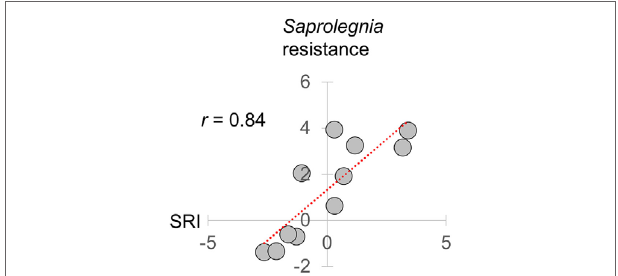
FigUre 3 | Relationship of seasonal reporter index (SRI) to an experimentally determined infectious disease phenotype. Resistance to Saprolegnia parasitica challenge adjusted for laboratory-determined thermal effects [the logit scale seasonal anti- Saprolegnia immunocompetence variable derived in Ref. (31)], plotted against mean monthly SRI. Results are based on the same 2014–2015 mesocosm run as in this study. SRI and Saprolegnia resistance were measured in separate groups of fish sampled contemporaneously (31). Pearson correlation coefficient ( r ) is shown in top